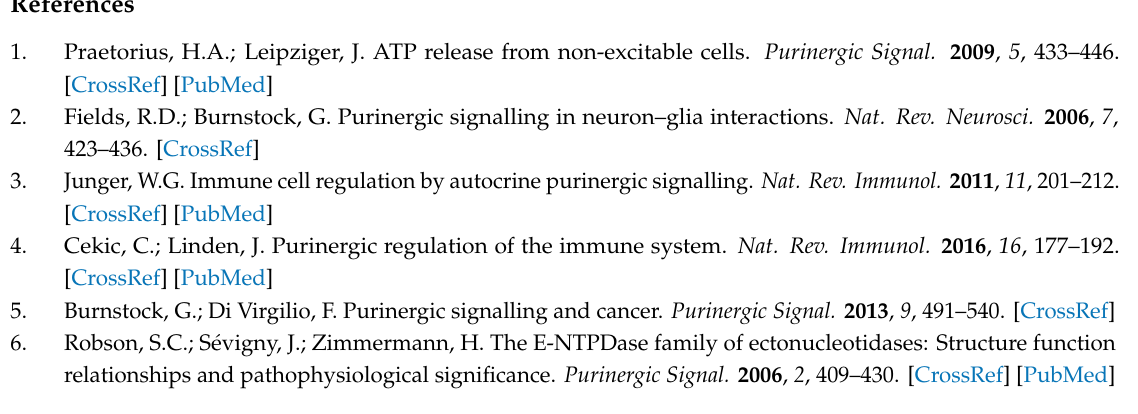
Figure S1: Luciferase-Based ATP and ADP Measurements; Figure S2: Live-cell response to 10 µ M ADP; Figure S3. Cell growth and death of transfected